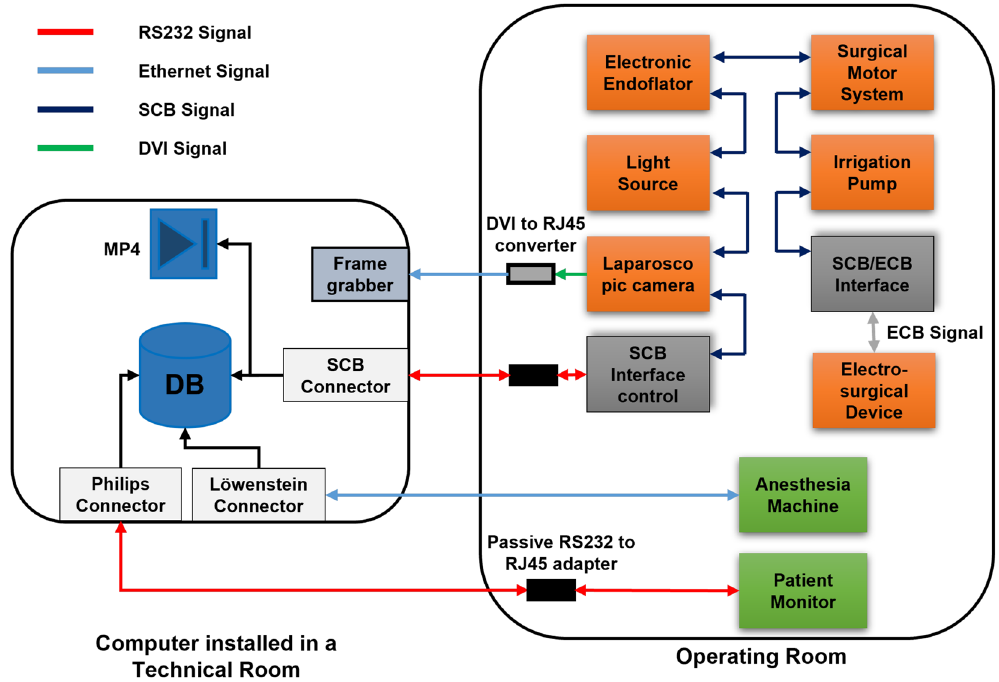
Figure 8. Schematic representative of the data recording system architecture. Philips Connecter, Löwenstein Connecter, and SCB Connector are the software for communicating with the patient monitor, anaesthesia machine, and surgical devices,